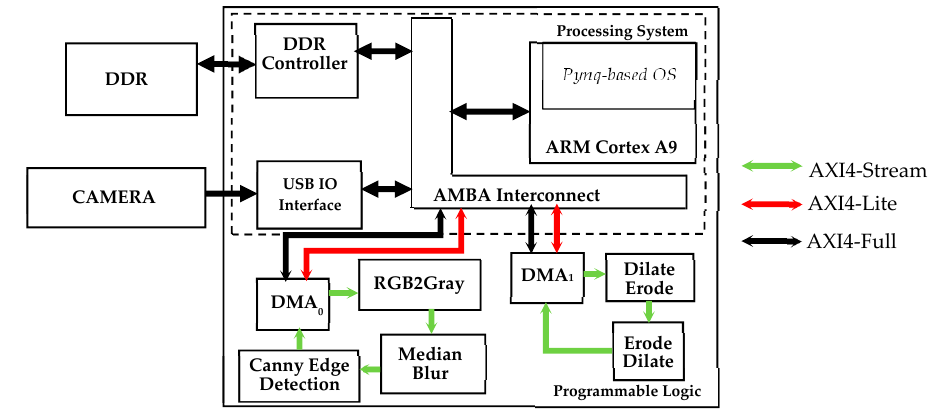
Figure 11. Top-level architecture of the designed embedded system.